Question: Provide a one-line summary of what is displayed.
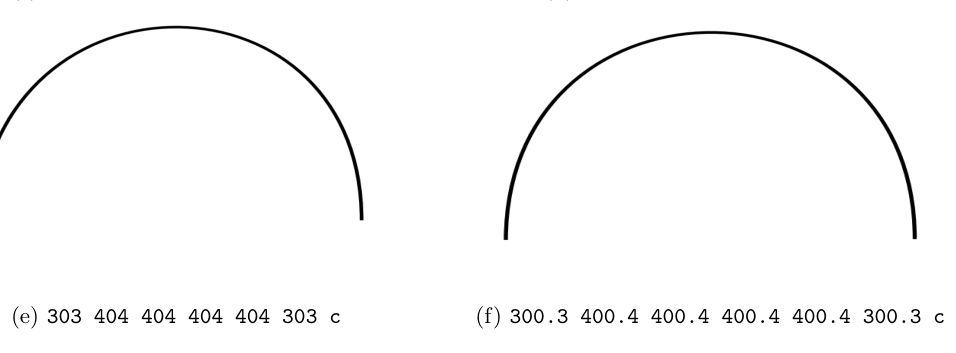
Answer: c Operator - control, 10%, 5%, 2% 1%, 0.1% (1%)